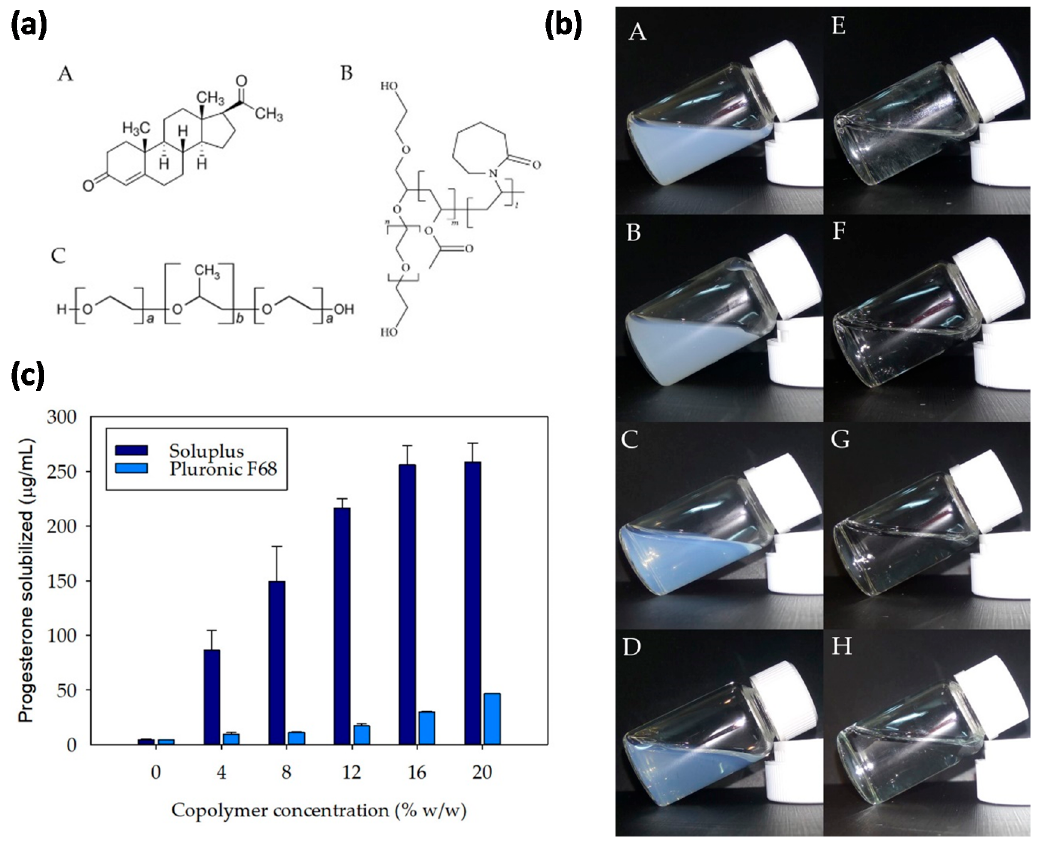
Figure 1. ( a ) Structure of progesterone (PG) (A), Soluplus ® (B), and Pluronic ® (C); ( b ) appearance of micelle dispersions (A) 16% Soluplus + PG, (B) 20% Soluplus + PG, (C) 16% Soluplus, (D) 20% Soluplus, (E) 16% Pluronic + PG, (F) 20% Pluronic + PG, (G) 16% Pluronic, and (H) 20% Pluronic; ( c ) PG solubility in Soluplus and Pluronic F68 micelle dispersions formulated in a phosphate saline buffer (PBS) pH 7.4. Error bars represent the standard deviations ( n = 3).